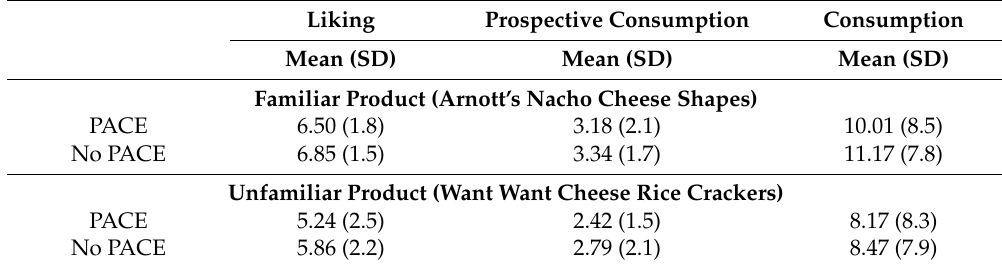
Table 4. Mean (SD) values of liking, prospective consumption and consumption for PACE and no PACE label for familiar and unfamiliar